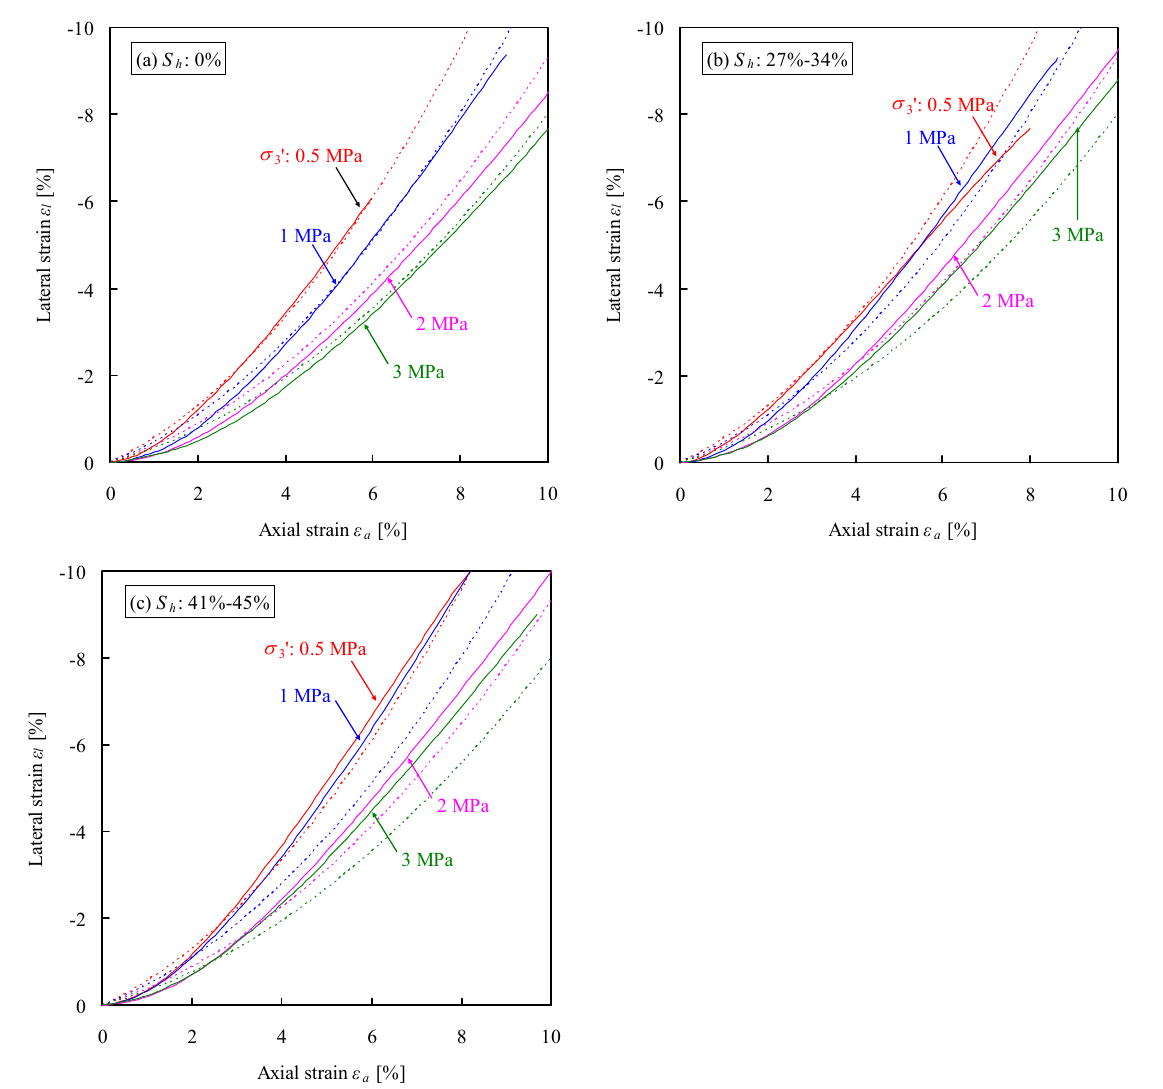
Figure 2. Experimental (solid lines) and calculated (broken lines) lateral strain ε for specimens formed by Toyoura sand with methane hydrate saturation S axial strain ε a ( a ) 0%; ( b ) 27%–34% and ( c ) 41%–45%. Experimental results are taken from the reference